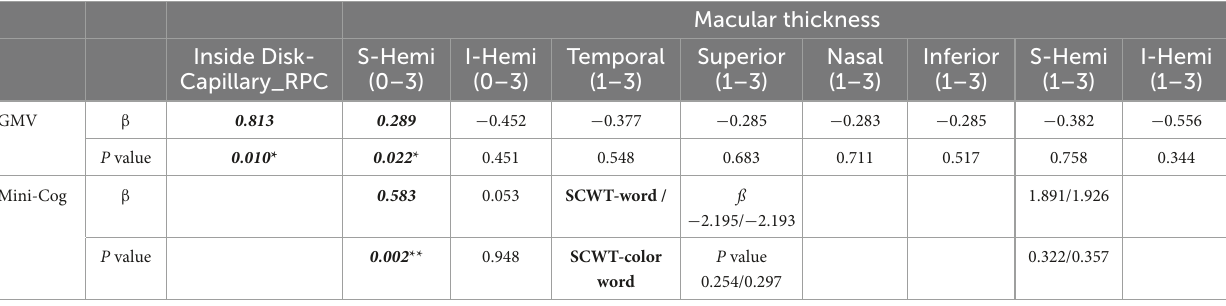
TABLE 5 Multivariable analysis of retinal parameters, neuroimaging parameters, and cognitive function in mild AD group with adjustment for age, gender, education, and